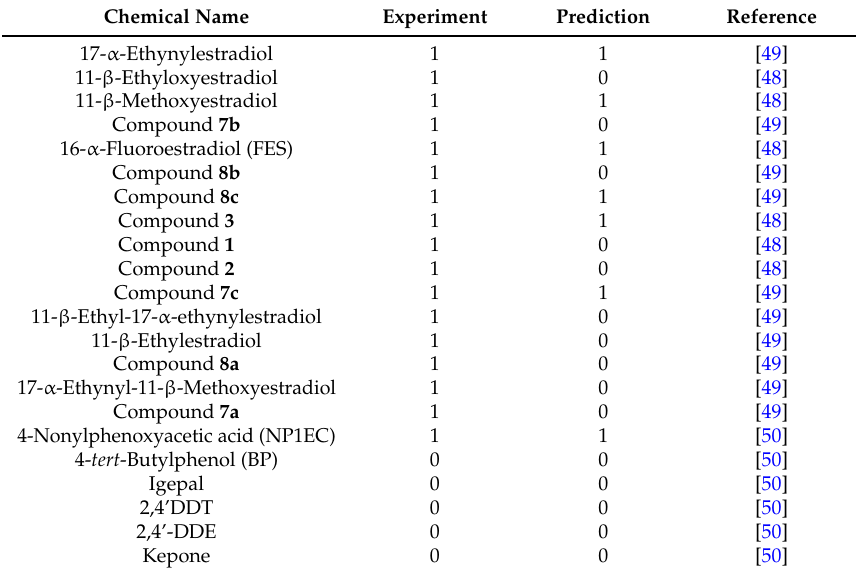
AFP binding data: 1 represents binder and 0 indicates